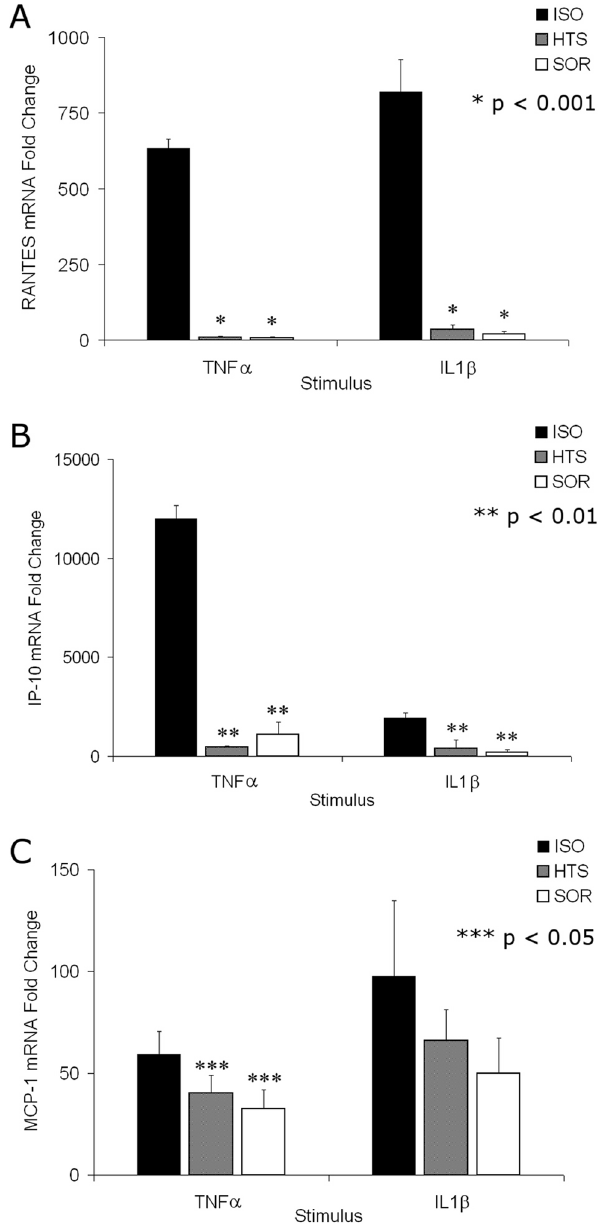
Figure 2. HOsm inhibits TNF a or IL-1 b stimulated mRNA for RANTES (A), IP-10 (B) and MCP-1 (C) chemokines in parallel with overall chemokine release levels. mRNA levels were measured following stimulation for 6 hours and normalized to constitutive GAPDH production after treatment with TNF a or IL-1 b in the presence of 400 mOsm HTS or Sorbitol. No significant differences were seen between any of the HTS and SOR